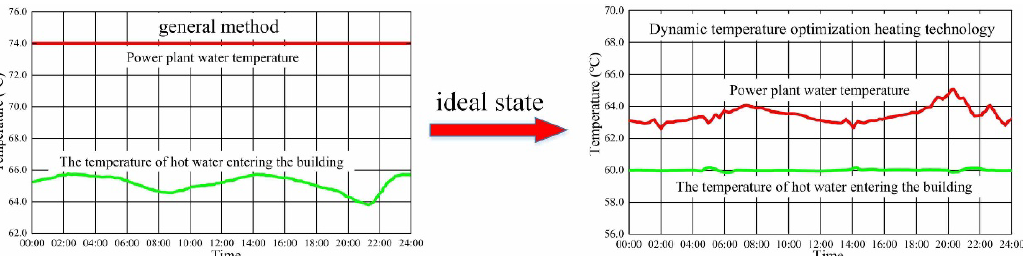
Figure 1. Two control modes of DH. One is the regulation method in which the temperature of the outlet water of the power plant is constant. The other is the regulation method in which the temperature of hot water entering the building is stable.